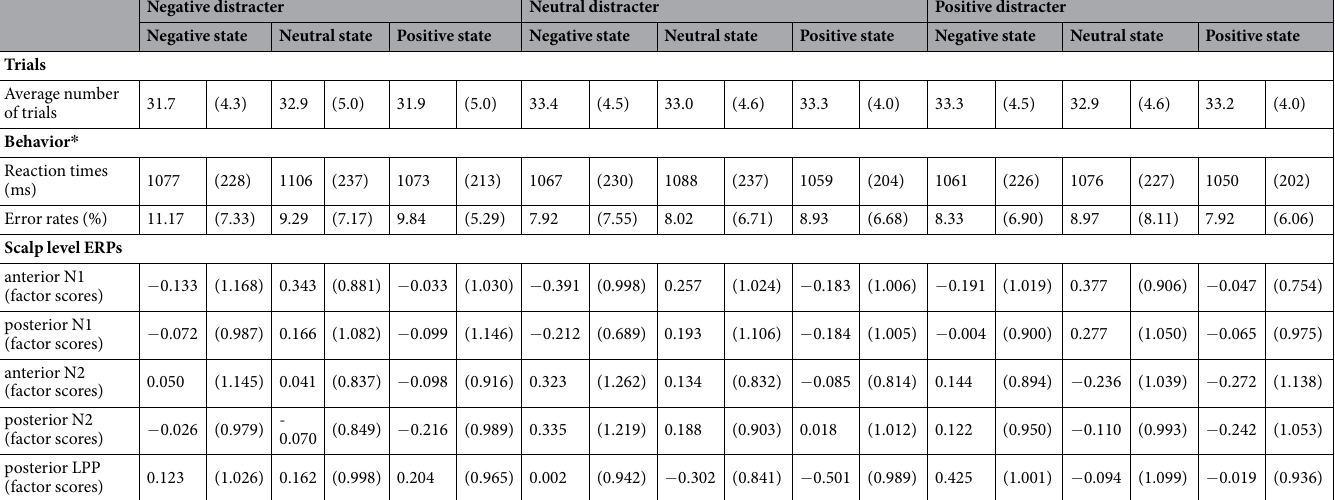
did not surpass the scree test cutoff because they did not account for a significant proportion of additional variance (i.e., the next one did not add more than 2% of additional variance). The sPCAs subsequently applied to all temporal factor scores extracted two spatial factors (SFs) for each of the temporal factors: one ante- rior or fronto-central and another posterior or parieto-occipital, explaining between 87 and 88% of variance. Temporal factor loadings of each component are represented as line plot in Fig. 4, and spatial factor loadings are shown as topographical plots. Original ERP amplitudes are a joint function of this factor loading wave- form/factor loading topographies and the factor scores multiplied together. Factor peak latency and topogra- phy characteristics associated the following components with those contained in our hypothesis: TF4 (peaking